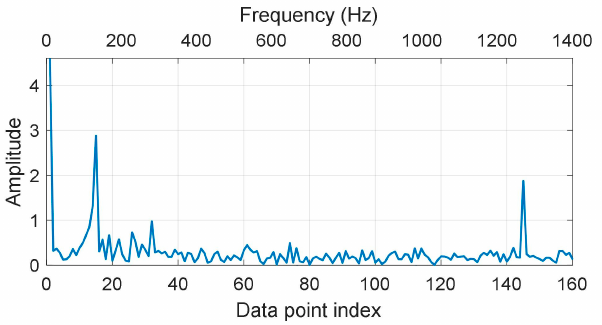
Figure 11. LGPG: frequency spectrum of compressed vibration signal.